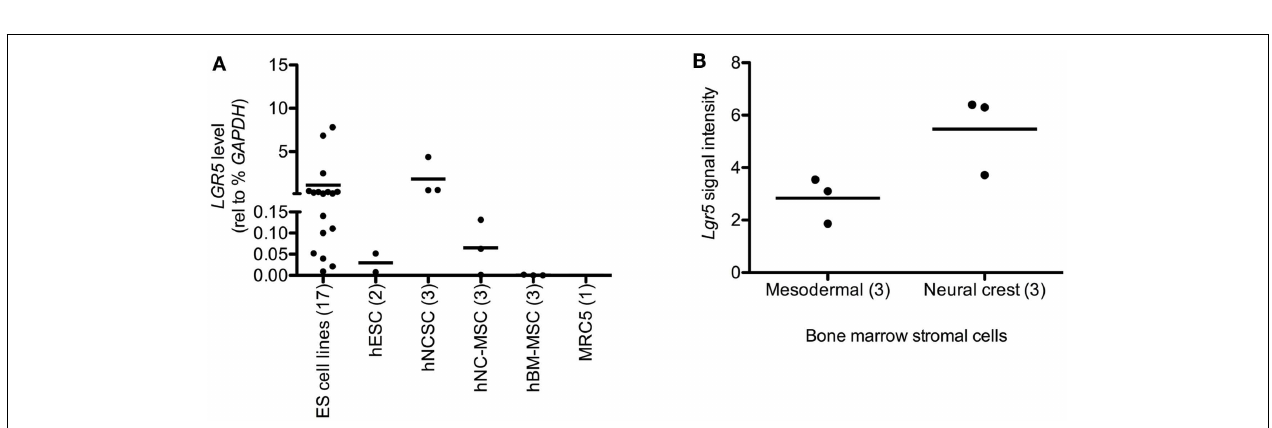
FIGURE 1 | Leucine-rich repeat-containing G-protein coupled receptor 5 is expressed by Ewing sarcomas. qRT-PCR analysis revealed low to very high-level expression of LGR5 in (A) 49 primary Ewing sarcoma (ES) and (B)